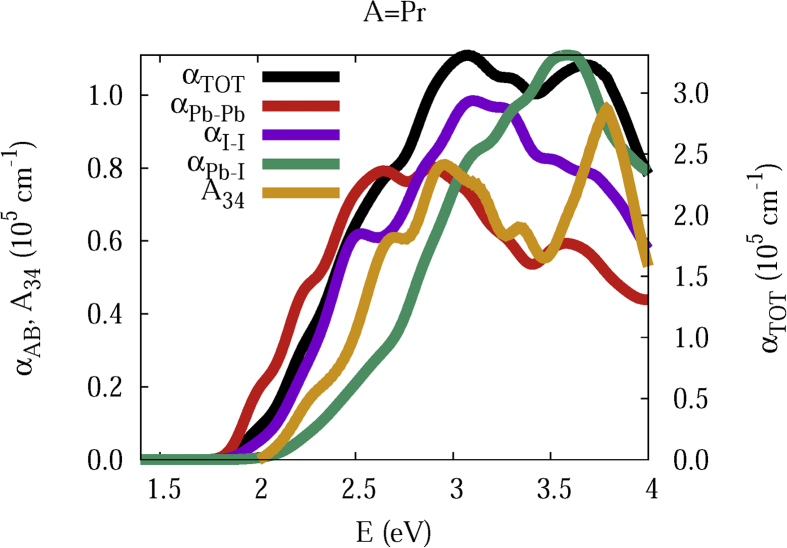
Same legend as that in Fig. 1, but for A = Pr.